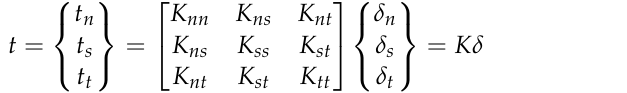
Figure 4. Model meshing.